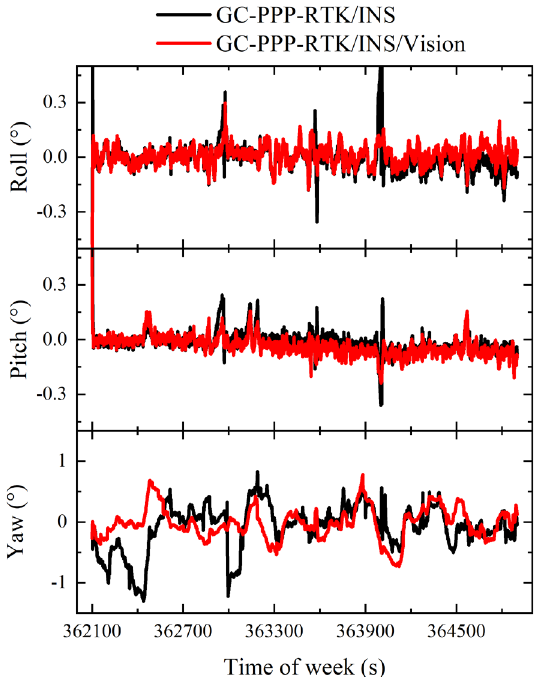
Figure 15. Attitude error series of GC-PPP-RTK/INS and GC-PPP-RTK/INS/vision for T02. Table 8. RMS of the attitude error of T01 for GC-PPP-RTK/INS and GC-PPP-RTK/INS/vision.